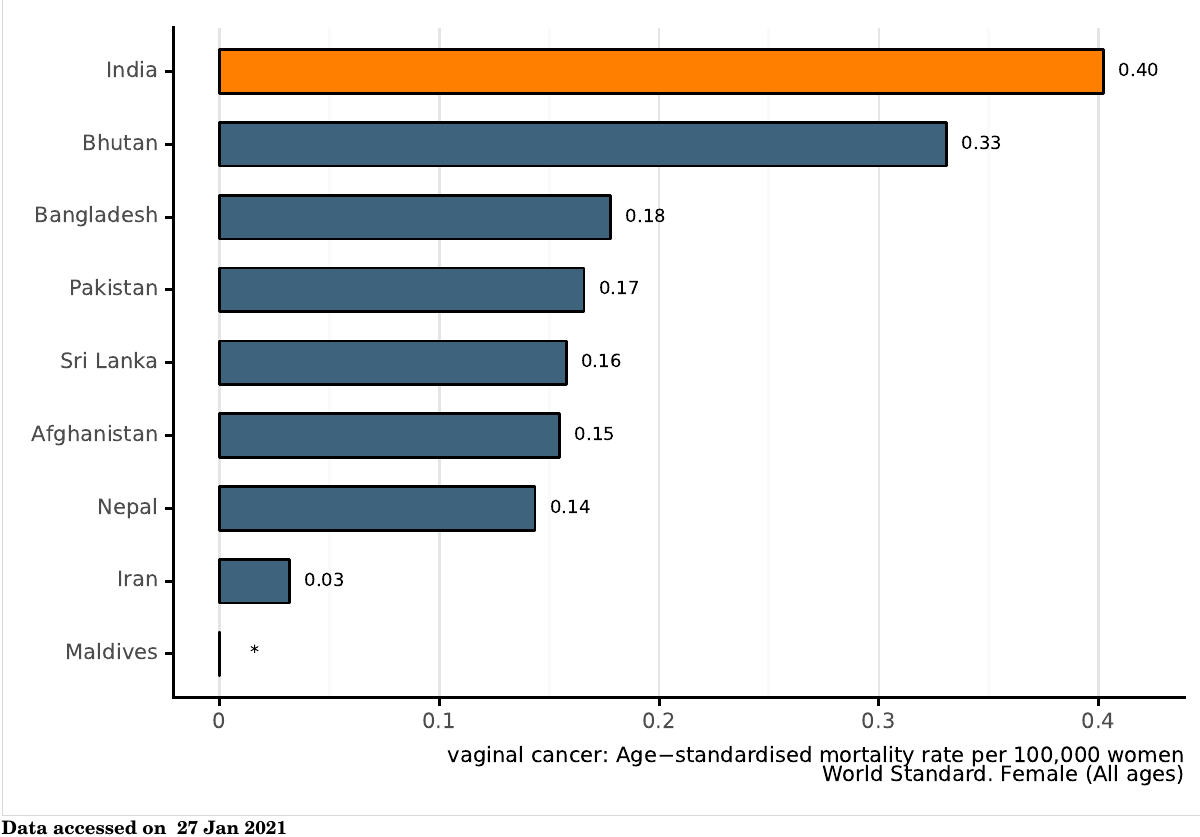
Figure 116: Age-standardised mortality rates of vaginal cancer of India (estimates for 2020)